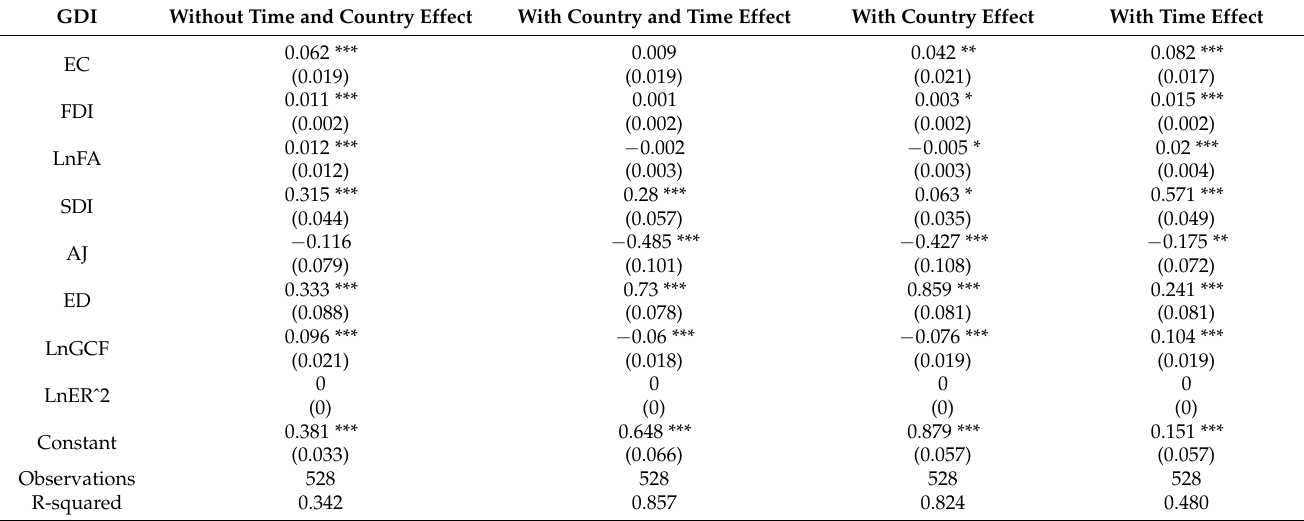
Table 3. Results of Simple Linear Regression 2000 − 2020 for 24 Asian Countries. Dependent variable: Gender Development Index (United Nations Reports).